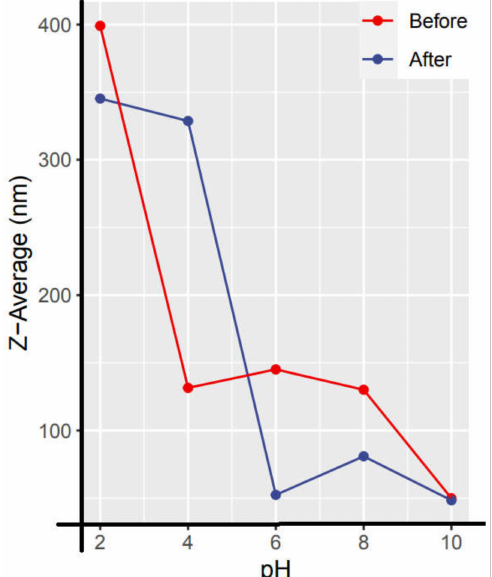
Figure 14. Average size (hydrodynamic diameter) of AuNPs obtained at different pH values.